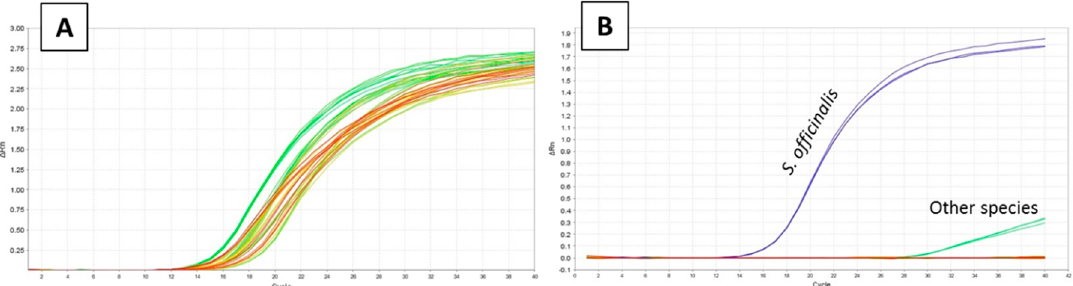
Figure 3. ( A ) Inclusivity test: amplification pattern of reference samples of Sepia officinalis . ( B ) Specificity test: amplification pattern of reference samples of Sepia officinalis and the rest of the species tested.